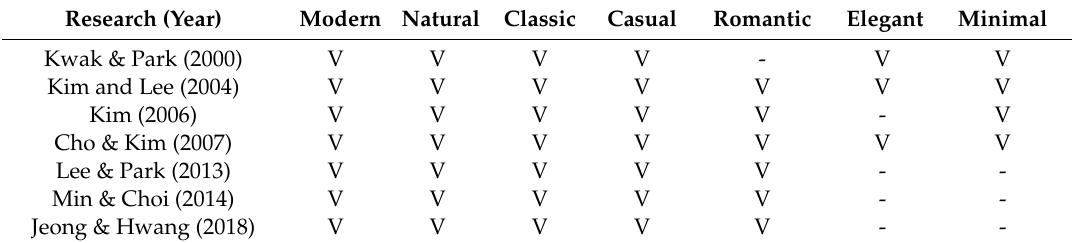
Table 2. Categories of design style represented in previous research studies (“V” indicates provided and “-” indicates not